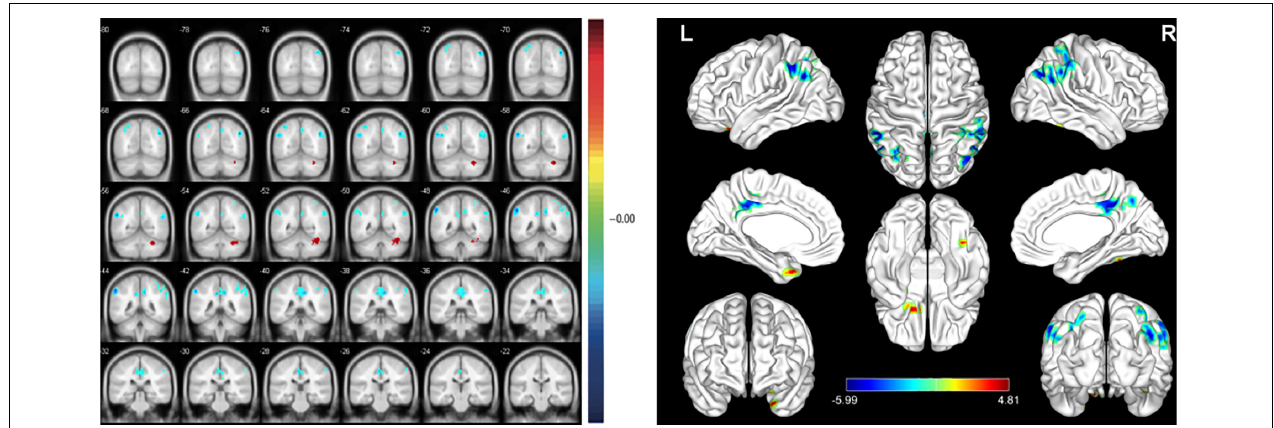
FIGURE 2 | Significant differences in spontaneous brain activity between the pre-rTMS (PRT) and post-rTMS (POT). The sizes of the spots denote the degree of quantitative changes. The different brain regions were observed in the Angular_R (AR), Parietal_Inf_L (PIL), Cingulum_Mid_R (CMR), Fusiform_R (FR) and Frontal_Inf_Orb_L (FIL). The red areas denote that PRT exhibit higher amplitude of low-frequency fluctuation (ALFF) in brain areas than POT and the blue areas denote brain regions with a lower ALFF [ P < 0.001, cluster > 13 voxels, Alphasim corrected)].